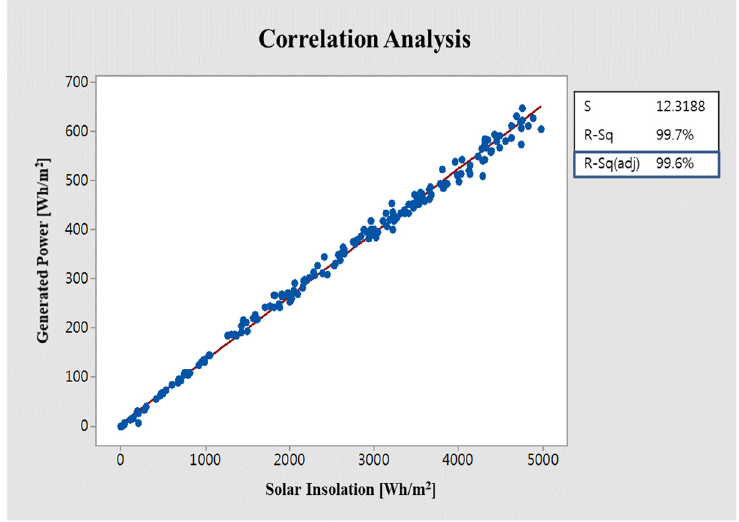
Figure 10. Analysis of the correlation between solar insolation and power generation (installation direction: west; installation angle: 3°).